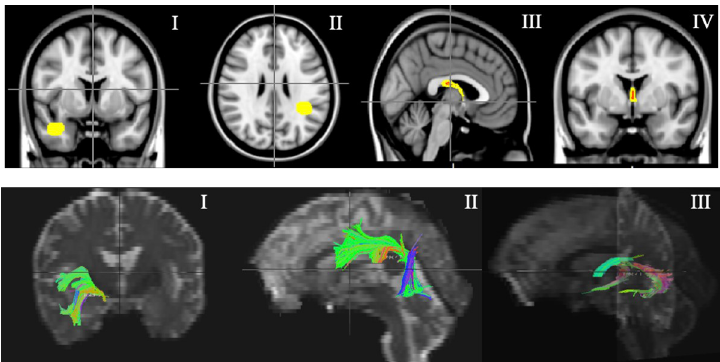
Fig 1. (A) Region-of-interest (ROI) placements for left uncinate fasciculus (UFL) (I), right superior longitudinal fasciculus (SLFR) (II) and fornix (III/IV). (B) Tract delineation for left uncinate fasciculus (UFL) (I), right superior longitudinal fasciculus (SLFR) (II) and fornix